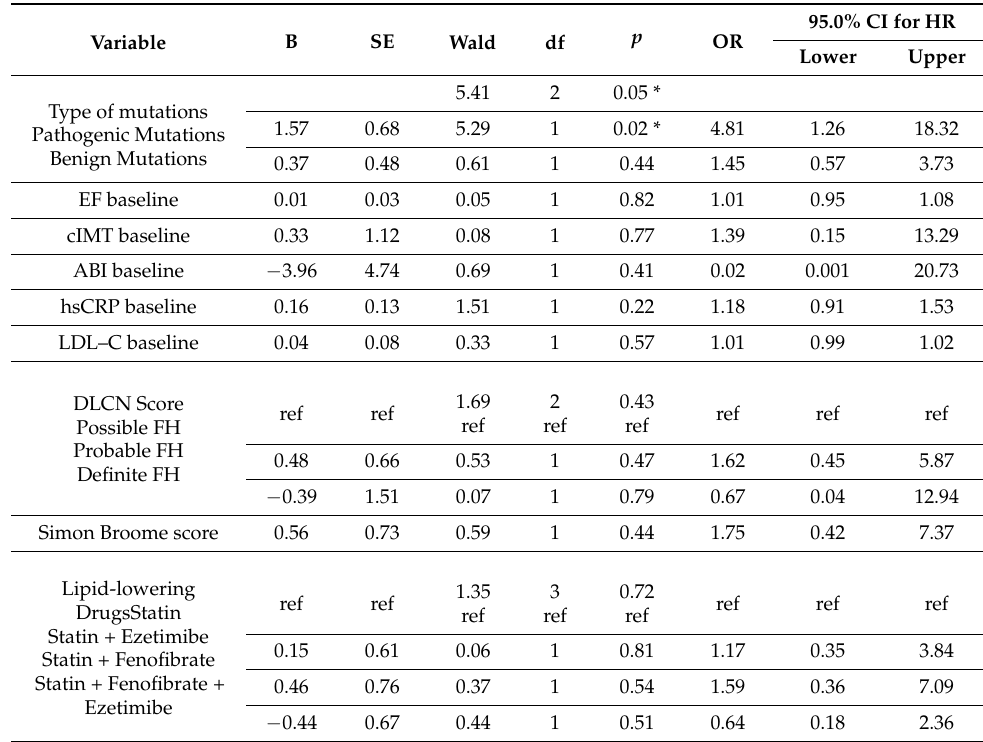
Table 4. Independent factors for cardiovascular events in FH patients.